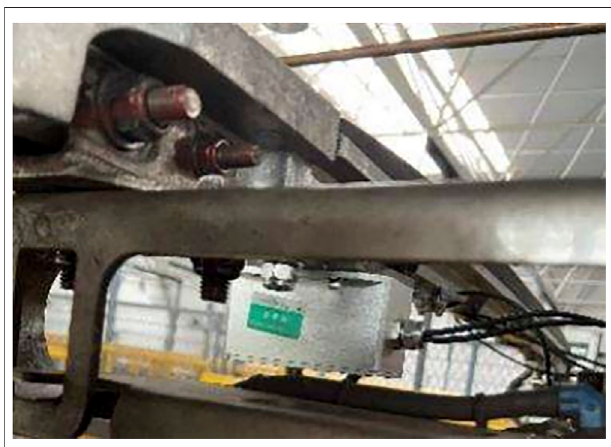
FIGURE 8 | Con fi guration of the sensors.